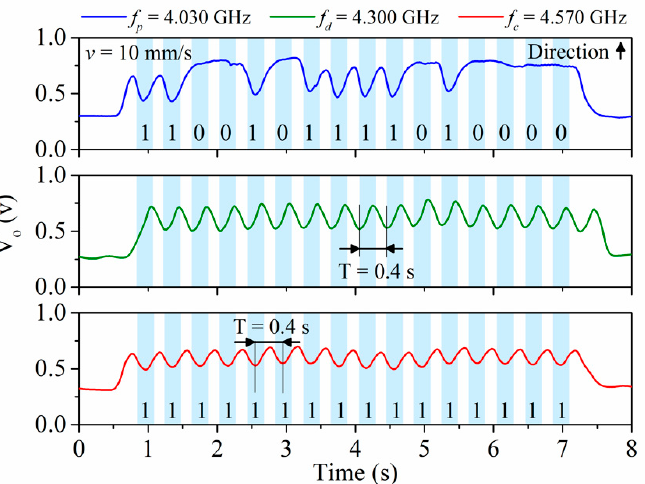
Figure 6. Measured envelope functions when the encoder of Figure 1 is displaced over the reader of Figure 2 at constant velocity of v = 10 mm/s. The vertical distance between the encoder and the reader is 0.2 mm.